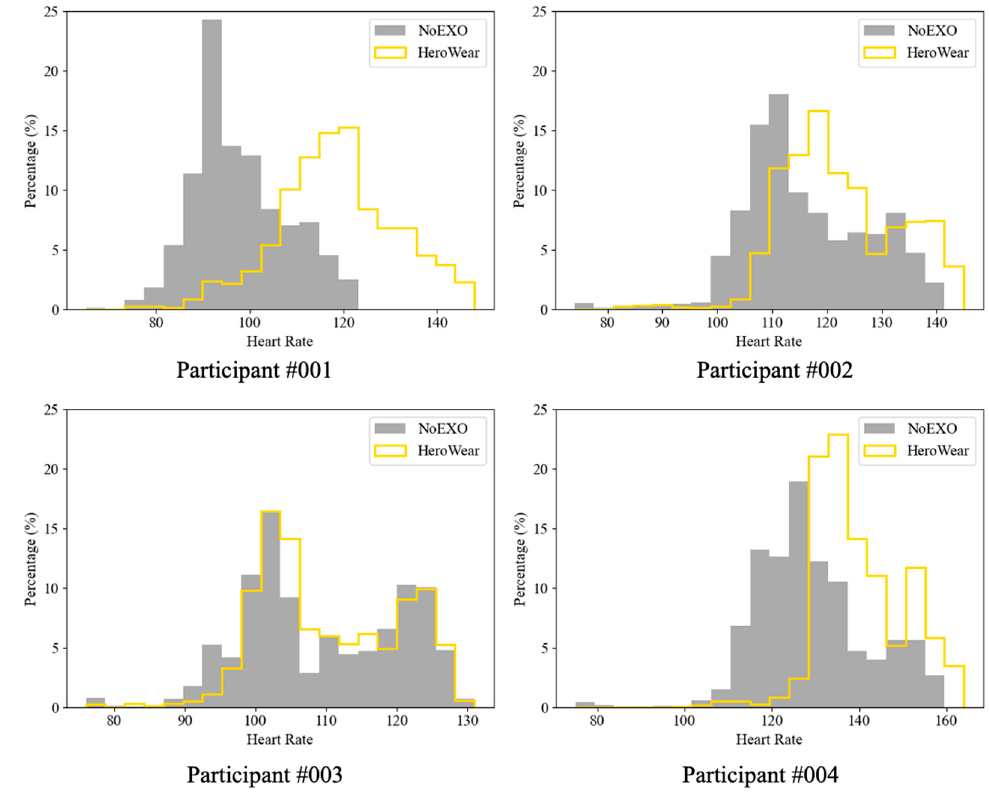
Figure 13. Completion time for Task 1 ( Left ) and Task 2 ( Right ).